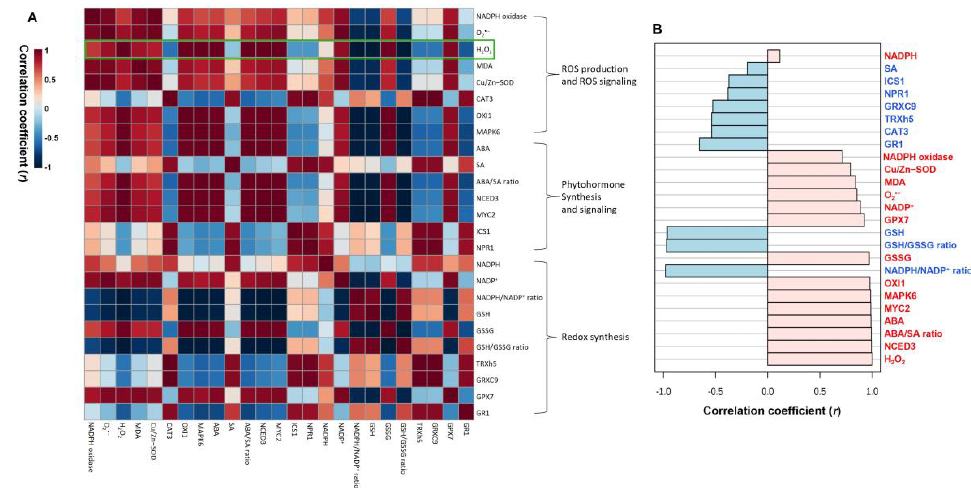
Figure 7. Heatmap responses of Pearson’s correlation coefficient ( r ) among the identified metabolites or gene expression levels ( A ) in the leaves of Brassica napus under control, drought, or drought with dimethylthiourea (Drought + DMTU) treatments at day 10. ( B ) The factors correlated with H 2 O 2 concentration. Red and blue indicate positive and negative correlation coefficients. Color intensity is proportional to the correlation